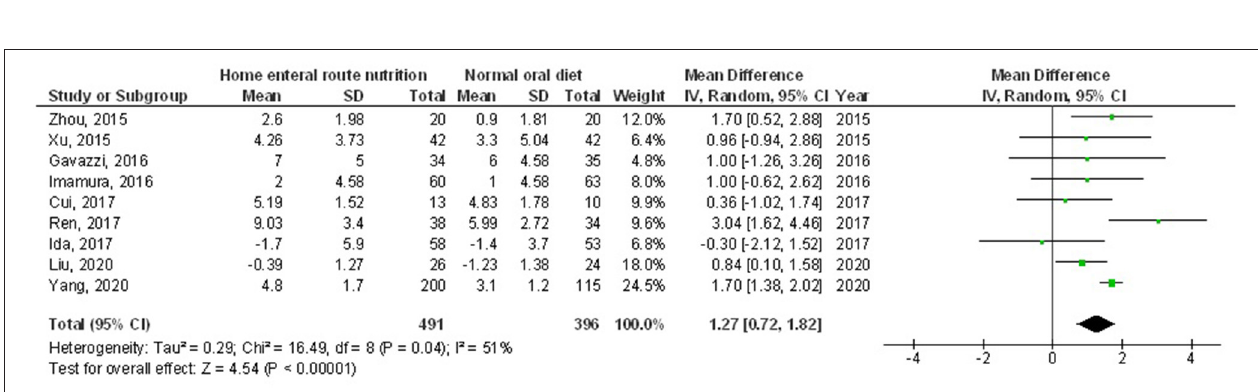
FIGURE 4 | A forest plot of the albumin in subjects with upper gastrointestinal cancer resection with the home enteral nutritional support compared to the normal oral diet.